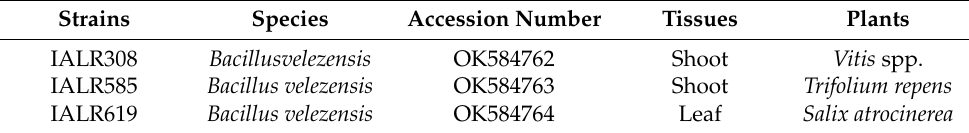
Table 1. Origination and identification of the bacterial